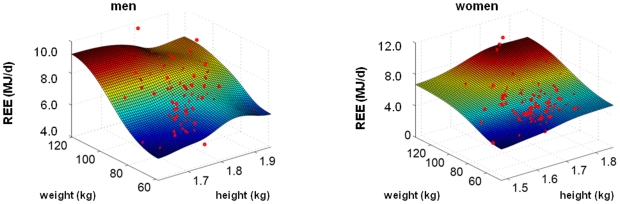
REE plotted against height and weight for men and women.